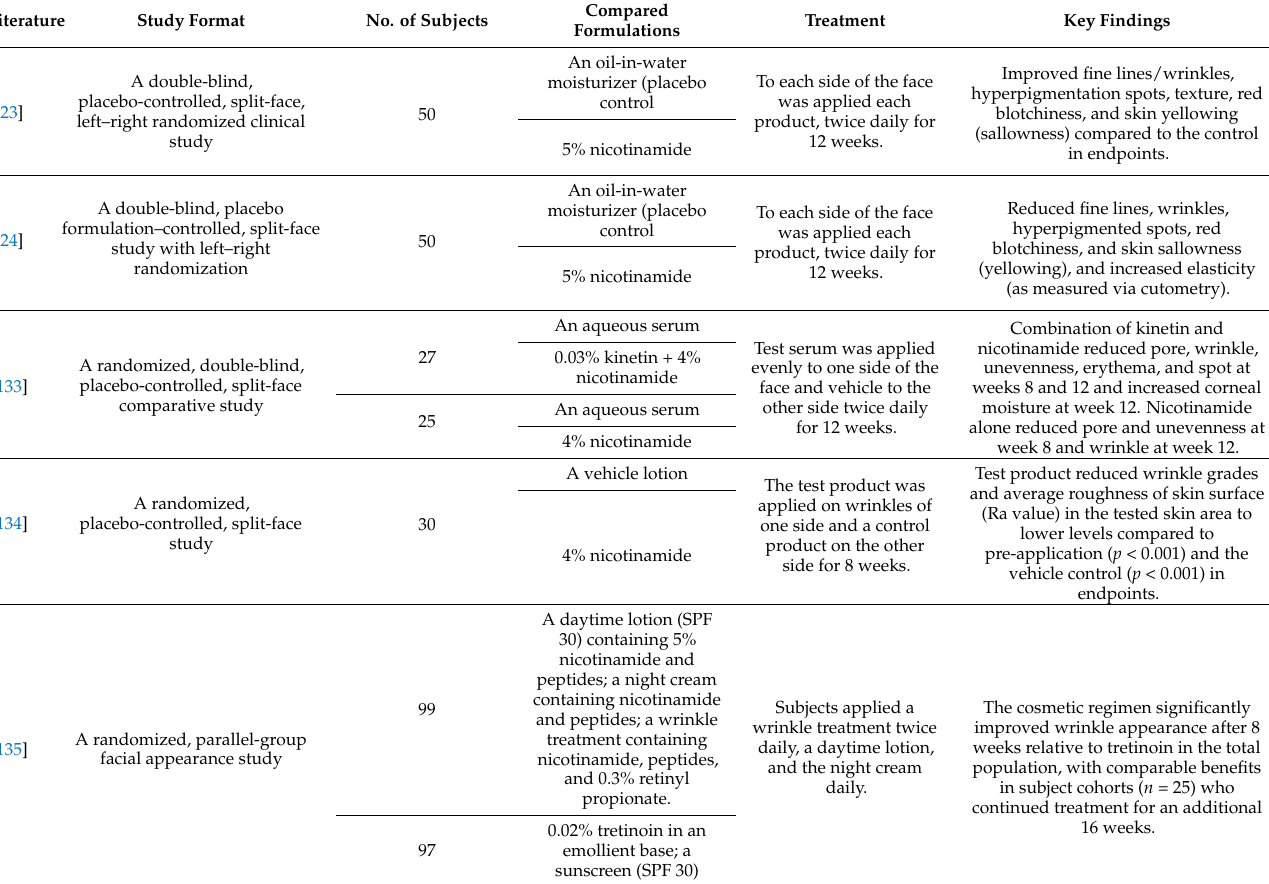
Table 1. Skin antiaging efficacy of cosmeceuticals containing nicotinamide alone or with other active